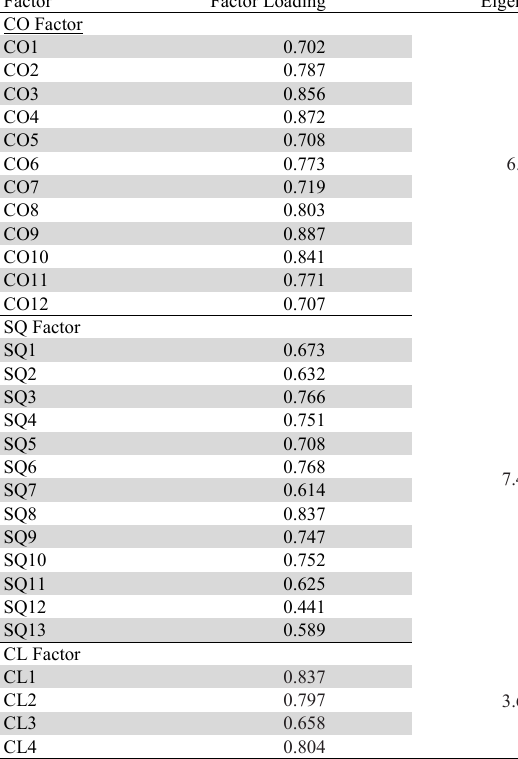
Table 1 Internal Consistency and Factor Loading Tests for CO, SQ &CL Factor Factor Loading